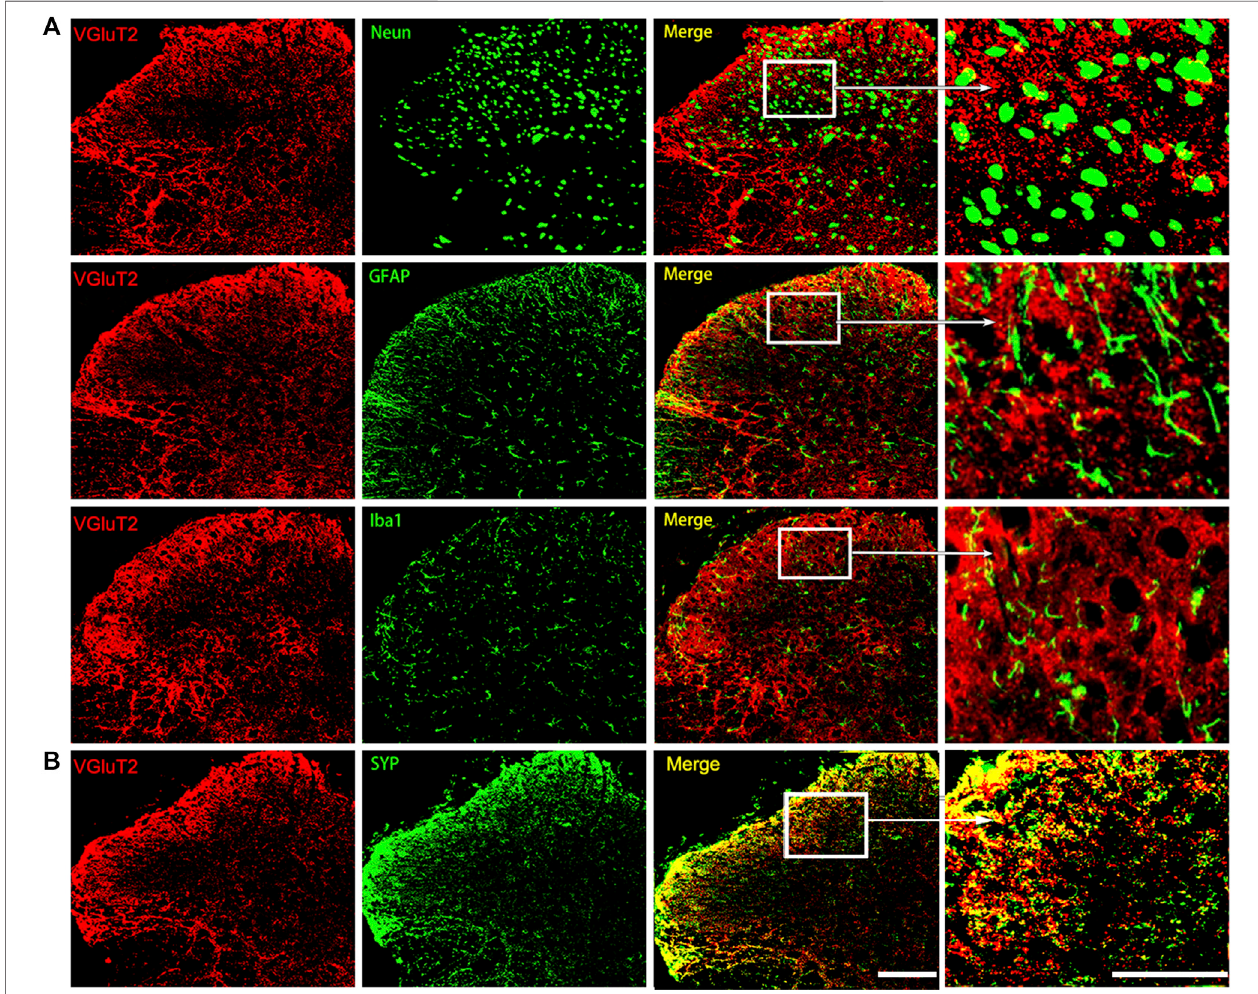
FIGURE2| Characterizationoftheexpressionpro fi leofVGluT2inthespinalcord (A) Representativeimmuno fl uorescenceimagesshowVGluT2iscolocalizedwith neurons (labeled by NeuN), astrocytes (labeled by GFAP), and microglia (labeled by Iba1) in the lumbar spinal dorsal horn from MT mice (B) Representative immuno fl uorescence images show VGluT2 is colocalized with synaptophysin (labeled by SYP) in the spinal dorsal horn from MT mice. n = 4. Scale bars, 100 μ m.